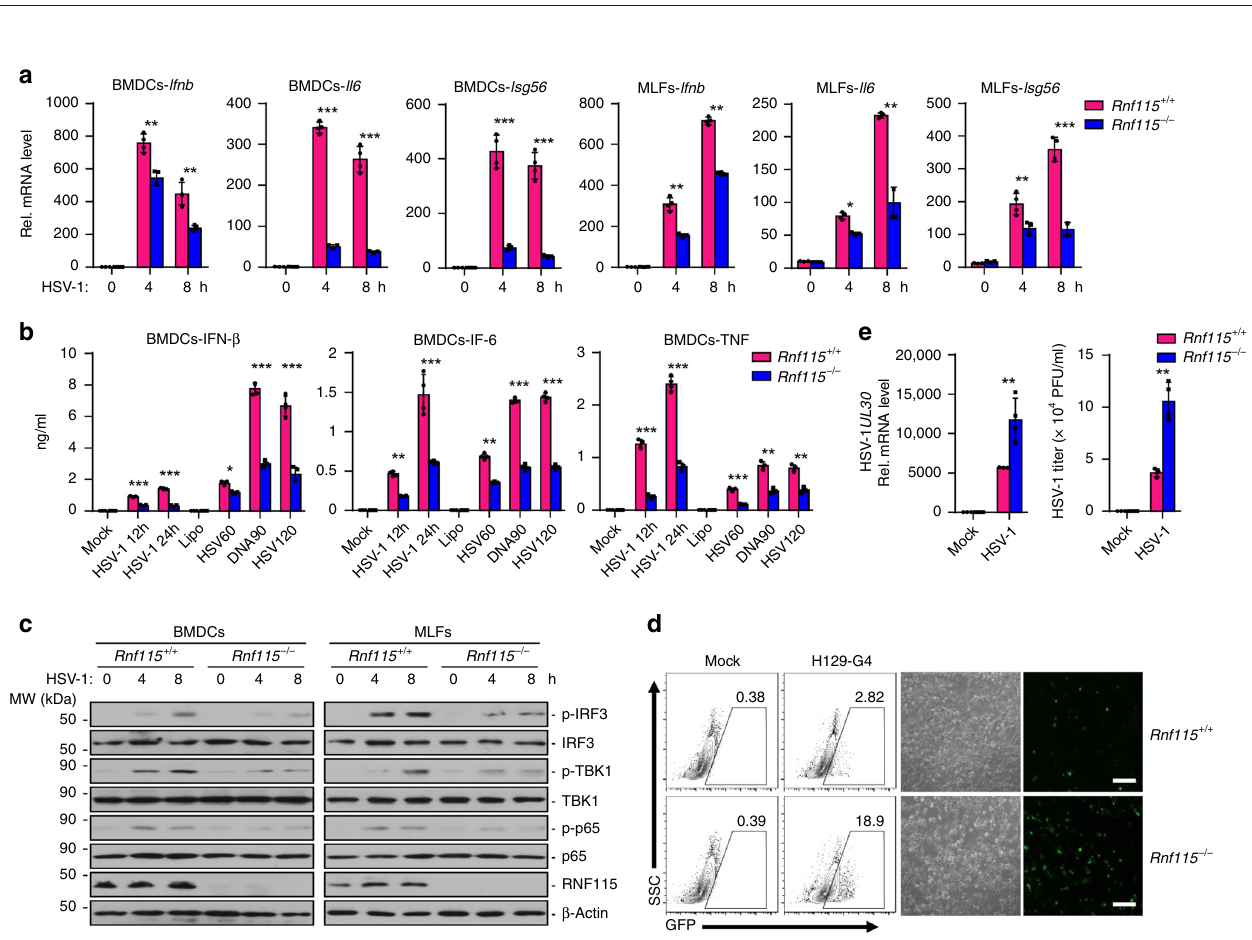
Fig. 2 RNF115 de fi ciency potentiates RNA virus-triggered signaling. a qRT-PCR analysis of Ifnb , Isg56 , or Ip10 mRNA in Rnf115 + / + and Rnf115 − / − BMDCs or MLFs infected with VSV or Sev for 0 – 12 h or transfected with poly(I:C) for 6 h. b ELISA analysis of IFN- β and CCL5 in the supernatants of Rnf115 + / + and Rnf115 − / − BMDCs or MLFs infected with VSV or SeV for 12 – 24 h, or transfected with poly(I:C) for 12 h. c Immunoblot analysis of total and phosphorylated (p-)I κ B α , IRF3, and TBK1, RNF115 and β -Tubulin in Rnf115 + / + and Rnf115 − / − BMDCs or MLFs infected with VSV for 0 – 8 h. d Flow cytometric analysis (left fl ow charts) and microscopy imaging (right images) of the replication of VSV-GFP (MOI = 0.5) in Rnf115 + / + and Rnf115 − / − BMDCs or MLFs left uninfected or infected with VSV-GFP for 1 h followed by twice PBS wash and cultured in full medium for 24 h. Numbers adjacent to the outlined areas indicate percentages of GFP + cells. e qRT-PCR analysis of VSV-N mRNA in Rnf115 + / + and Rnf115 − / − BMDCs or MLFs left uninfected or infected with VSV for 1 h followed by twice PBS wash and cultured in full medium for 24 h (left graphs). Plaque assay of VSV replication in the supernatants of Rnf115 + / + and Rnf115 − / − BMDCs or MLFs infected with VSV for 1 h followed by twice PBS wash and cultured in full medium for 48 h (right graphs). * P < 0.05, ** P < 0.01, and *** P < 0.001 (two-tailed Student ’ s t -test). Scale bars represent 200 μ m. Data are representative of three independent experiments (graphs show mean ± SD in a , b , e ). Source data are provided as a Source Data fi le.